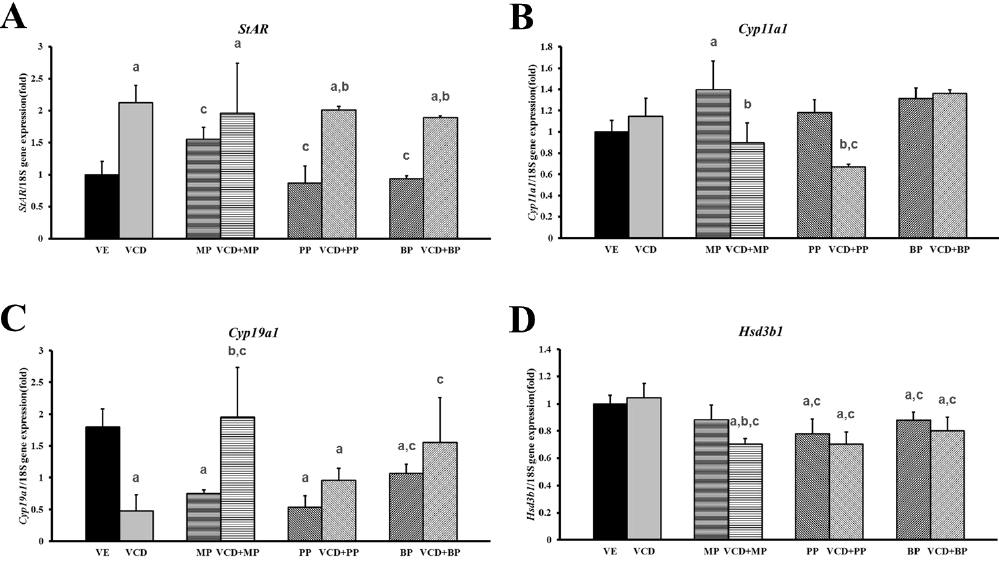
Figure 5. Effects of VCD and parabens on the mRNA expression of steroidogenic enzymes in rats ovaries. The expressions of Star , Cyp11a1 , Cyp19a1 and Hsd3b1 gene were measured by real-time PCR and normalized by Rn18s . ( A ) Star ; ( B ) Cyp11a1 ; ( C ) Cyp19a1 ; ( D ) Hsd3b1 . a p < 0.05 vs. VE, b p < 0.05 vs. paraben, c p < 0.05 vs. VCD. Data are presented as the mean ± SD. VE 20% Et-OH, VCD 40 mg/kg/day, MP, PP, BP; 100 mg/kg/day.